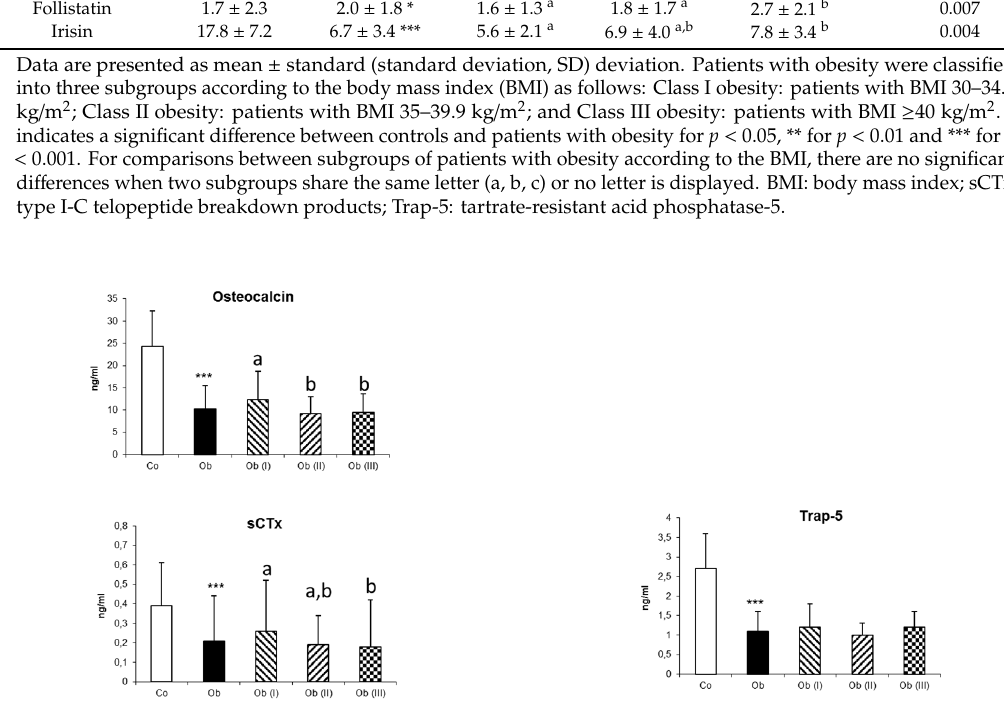
Figure 1. Markers of bone turnover in controls (CO) and in patients (Ob) according to the class of obesity. Data are presented as mean ± standard deviation. Patients with obesity were classified into three